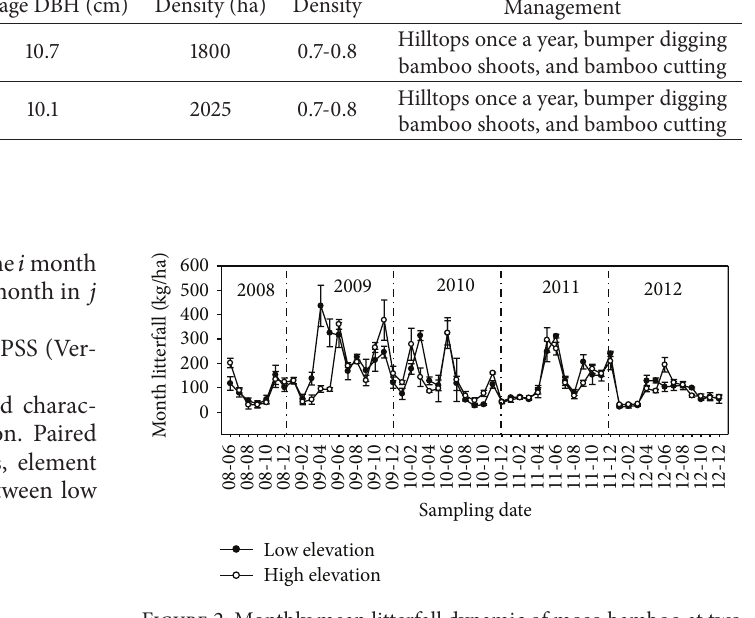
Figure 2: Monthly mean litterfall dynamic of moso bamboo at two elevations from June 2008 to December 2012. The years of 2008, 2010, and 2012 were on-years, while the years of 2009 and 2011 were off-years in our study area.